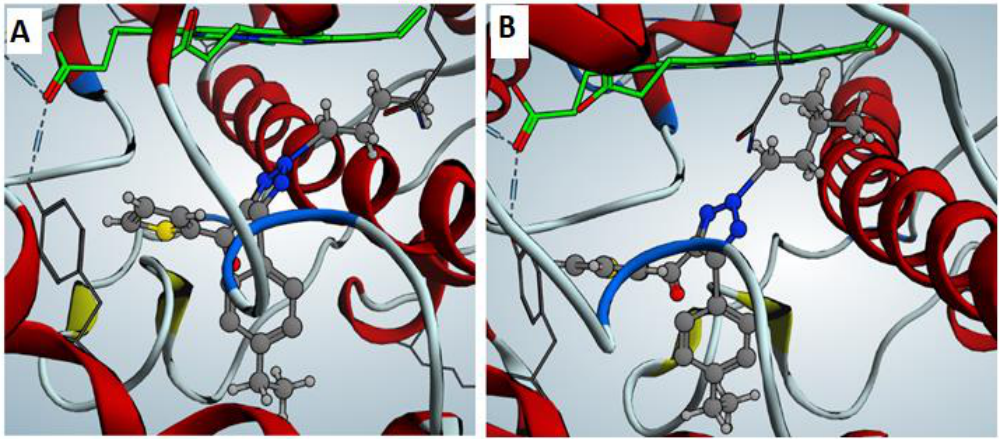
Figure 7. ( A ) Docking pose of compound GKV12. ( B ) Docking pose of compound GKV14.